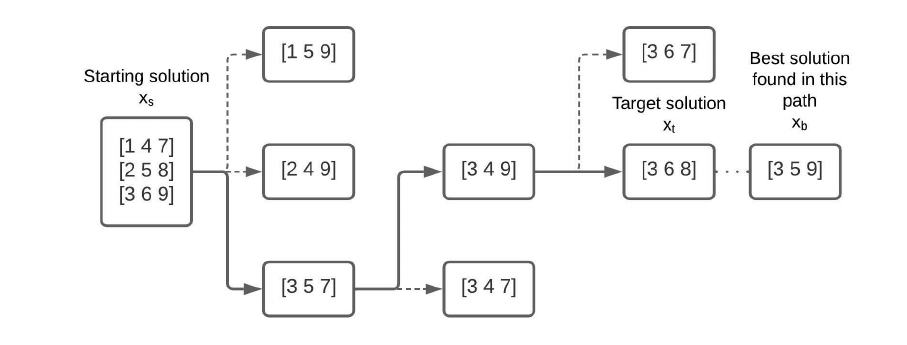
Figure 1. Example of Path Relinking applied to the DSR